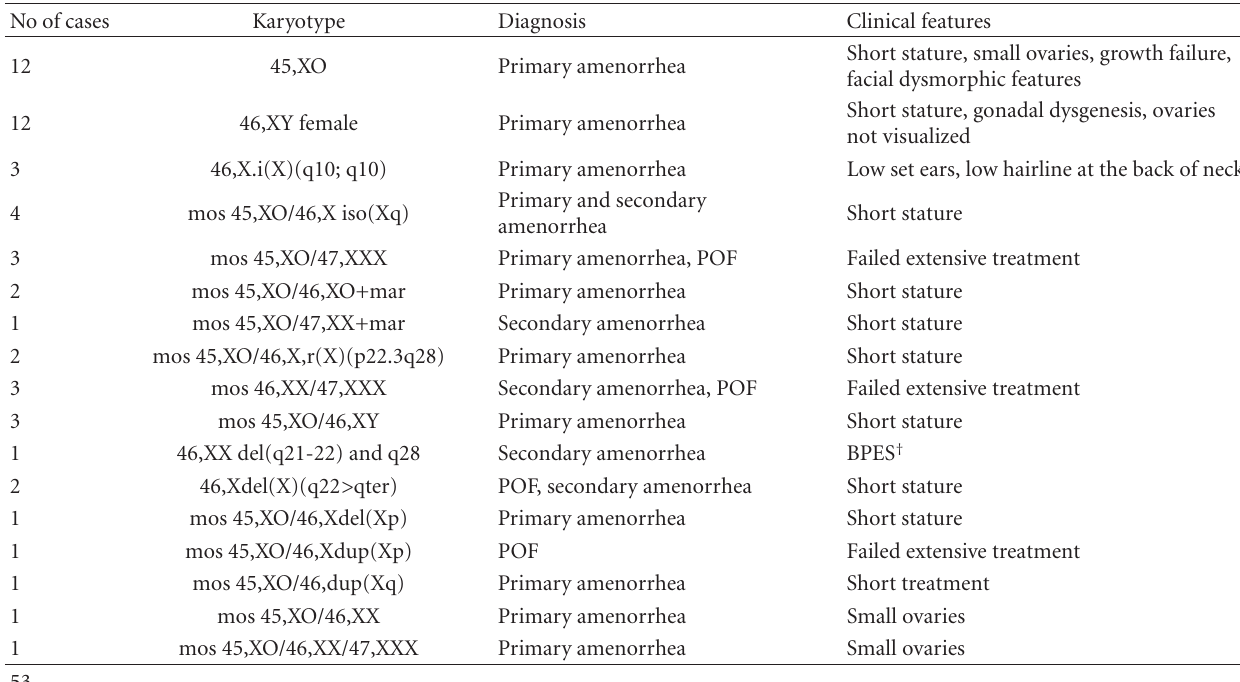
Table 1: Cytogenetic findings in 53 cases with abnormal X